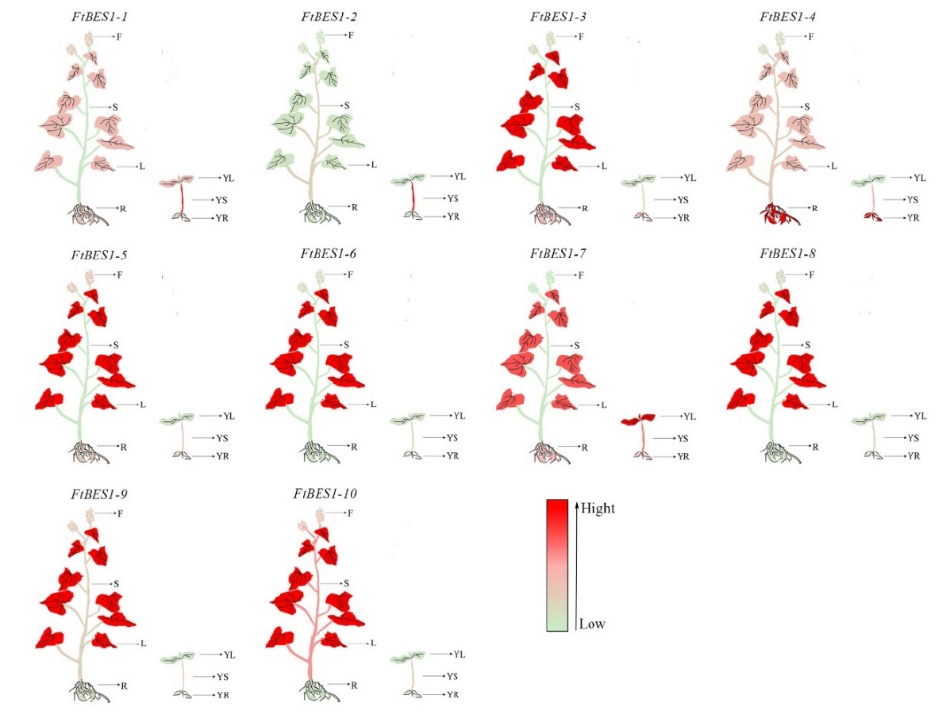
Figure 5. Expression levels of FtBES1 gene in different tissues at two different periods. YL; young leaf; YS: young stem; YL: young root; F: Flower; S: Stem; L: Leaf; R: Root. The average expression values of different tissues at two different periods were calculated from three independent biological replicates relative to the root expression levels.